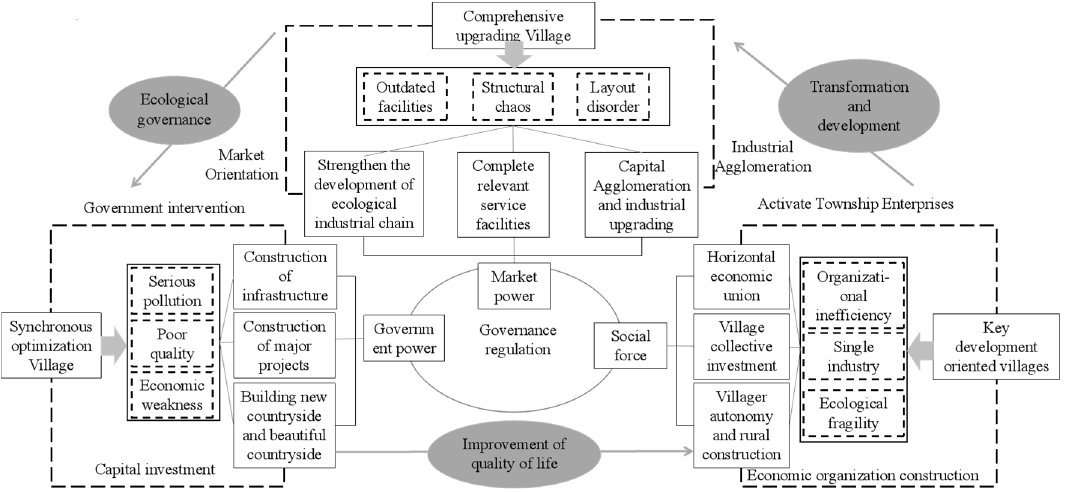
Figure 6. Governance paths in rural development zones in Yongchang County.